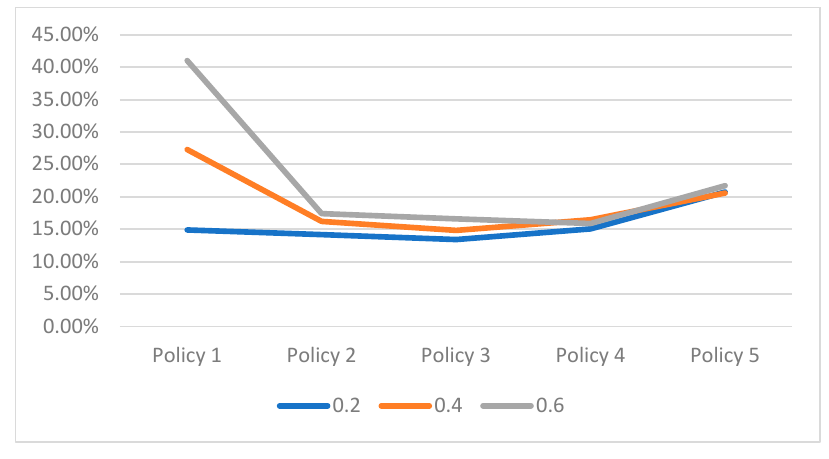
Figure 5. Parts delayed.